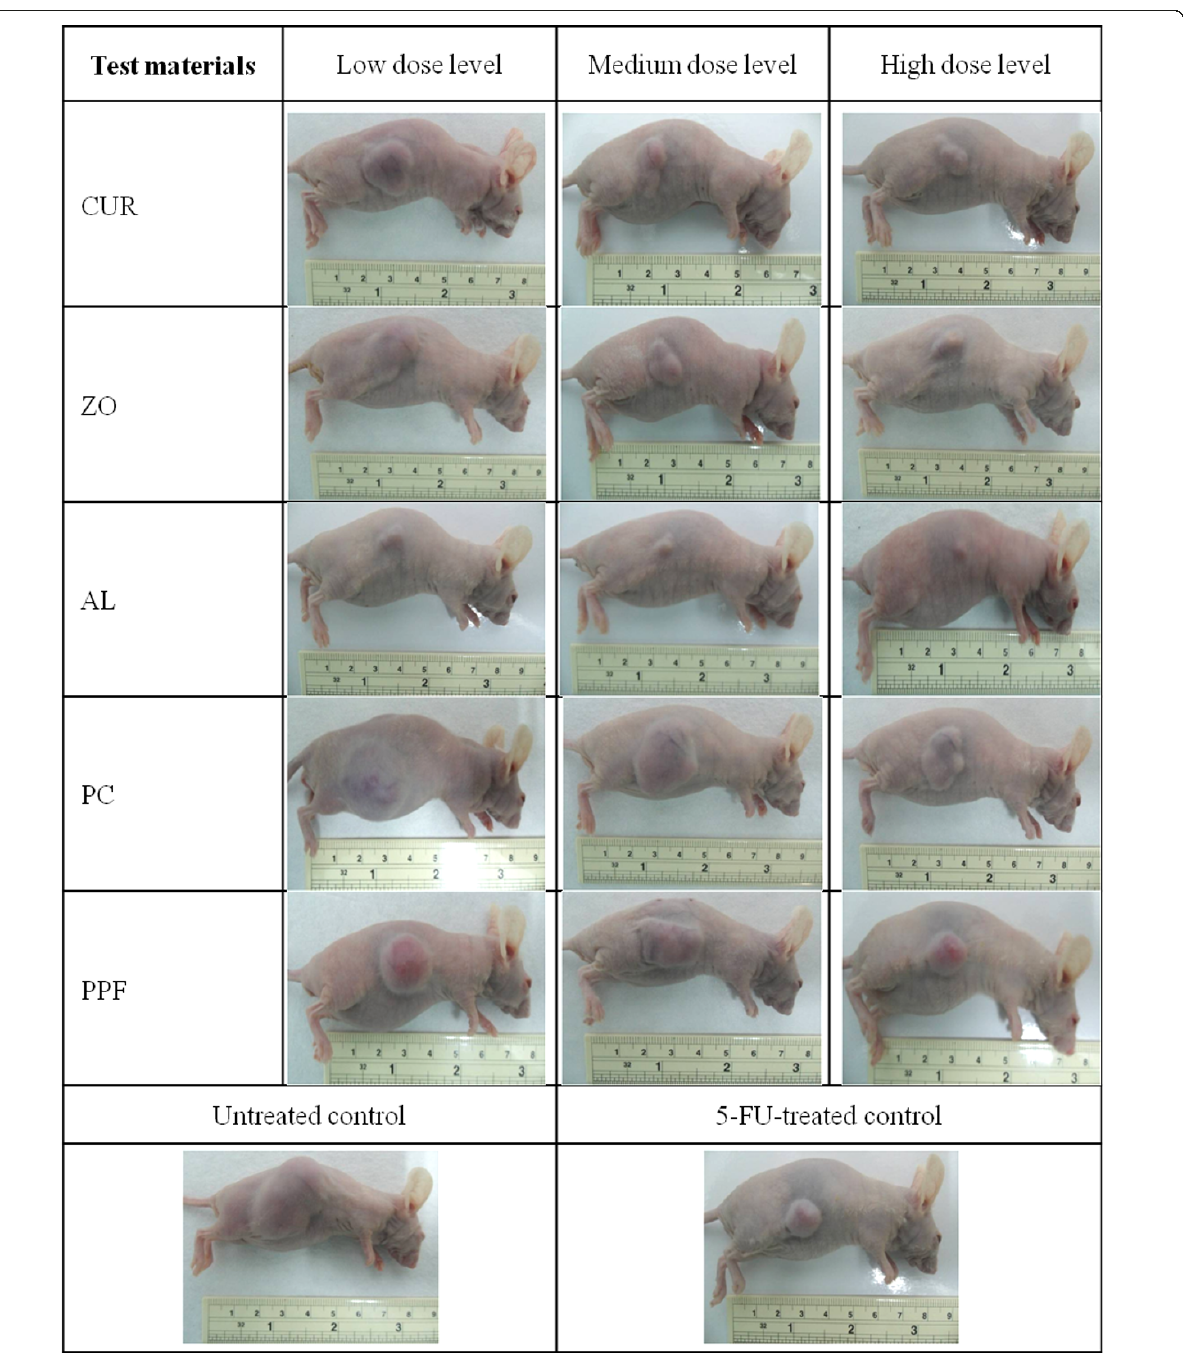
Figure 2 Representative tumors of CCA-xenografted nude mice following treatment with the test materials (CUR compound and extracts of ZO, AL, PC, and PPF at various dose levels) in comparison with untreated control and 5-FU (reference control)